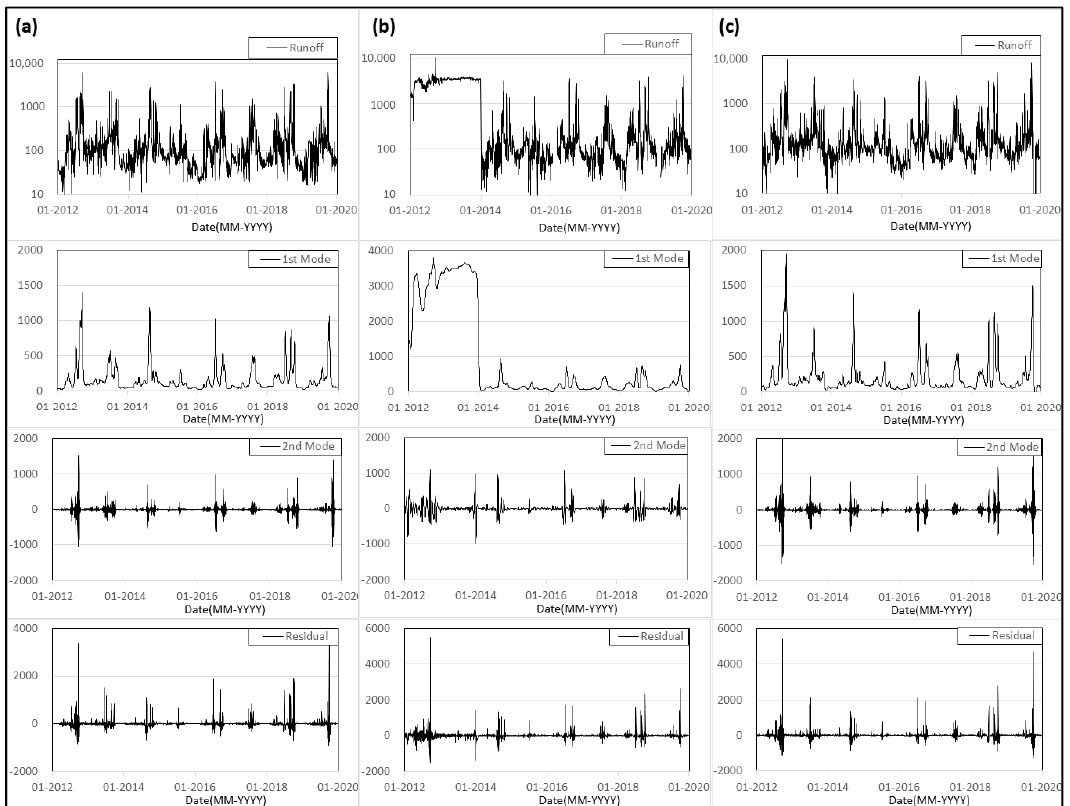
Figure 5. Decomposed result with variational mode decomposition (VMD): ( a ) station A, ( b ) station B, ( c ) station C, and each runoff series decomposed into two modes and residual mode.